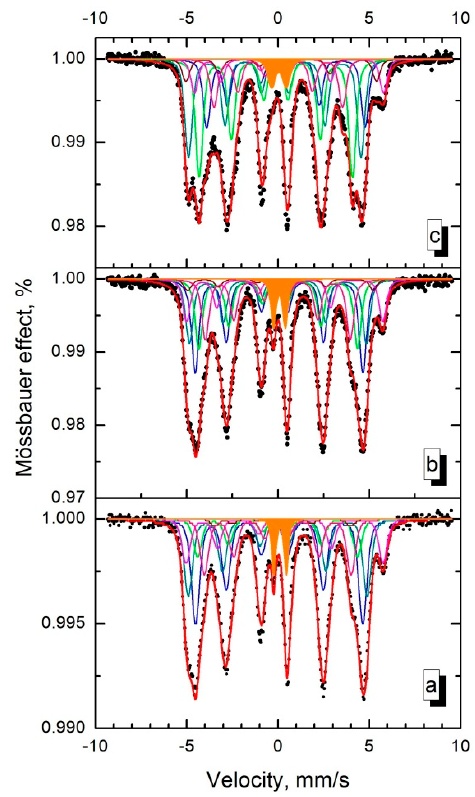
Figure 7. Mössbauer spectra of the SG1 ( a ), SG2 ( b ) and SG3 ( c ) samples after annealing at 600 °C for 30 min with a paramagnetic doublet marked. Table 3. Mössbauer spectra parameters of SG1, SG2 and SG3 samples annealed at 600 °C for 30 min. Mössbauer